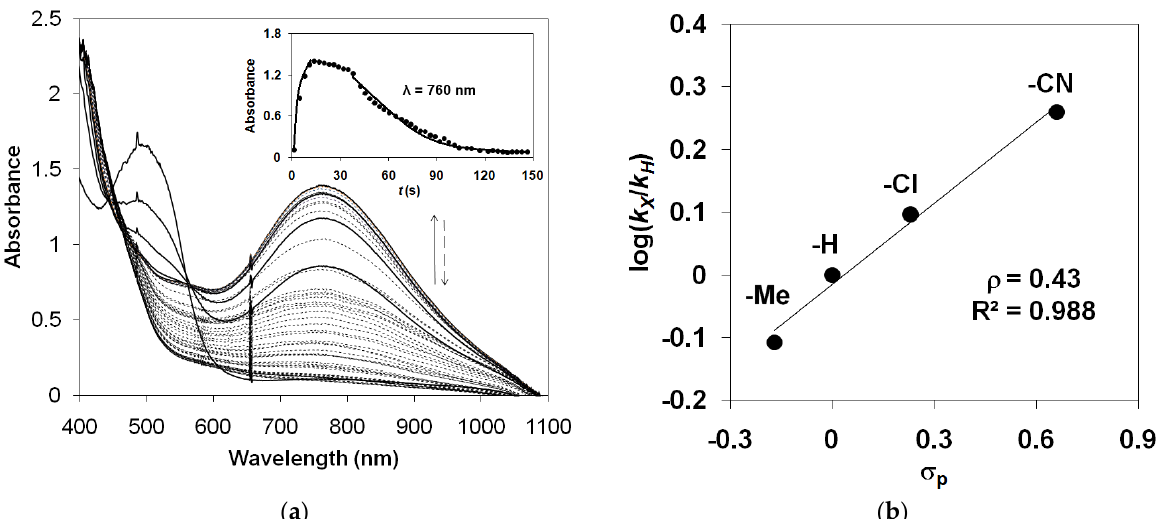
Figure 8. Spectral changes during the reaction of 3 with benzaldehyde under air: ( a ) UV–Vis absorption spectra of complex 3 after the addition of 15 equivalents of benzaldehyde under air. Conditions: [ 3 ] = 1 mM, [BA] = 15 mM, λ = 760 nm. ( b ) Hammett plot for the reaction of the in situ formed 3BA/O 2 intermediate with the excess of benzaldehyde derivatives. Conditions [ 3 ] = 1 mM, [4R-BA, R = Me, H, Cl, and CN] = 20 mM in MeCN at 5 °C.